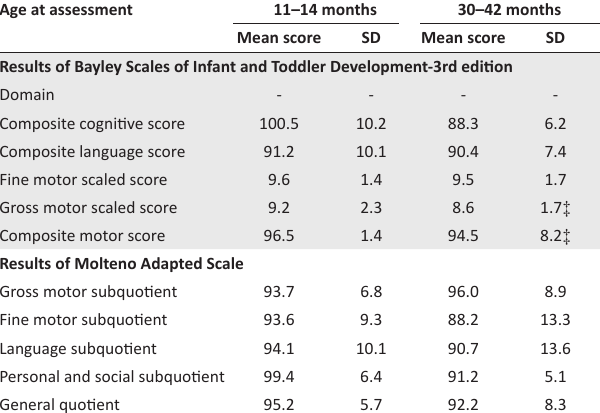
TABLE 1: Performance on the Bayley Scales of Infant and Toddler Development- 3rd edition and Molteno Adapted Scale at 11–14 months ( n = 90) and 30–42 months ( n = 53). †